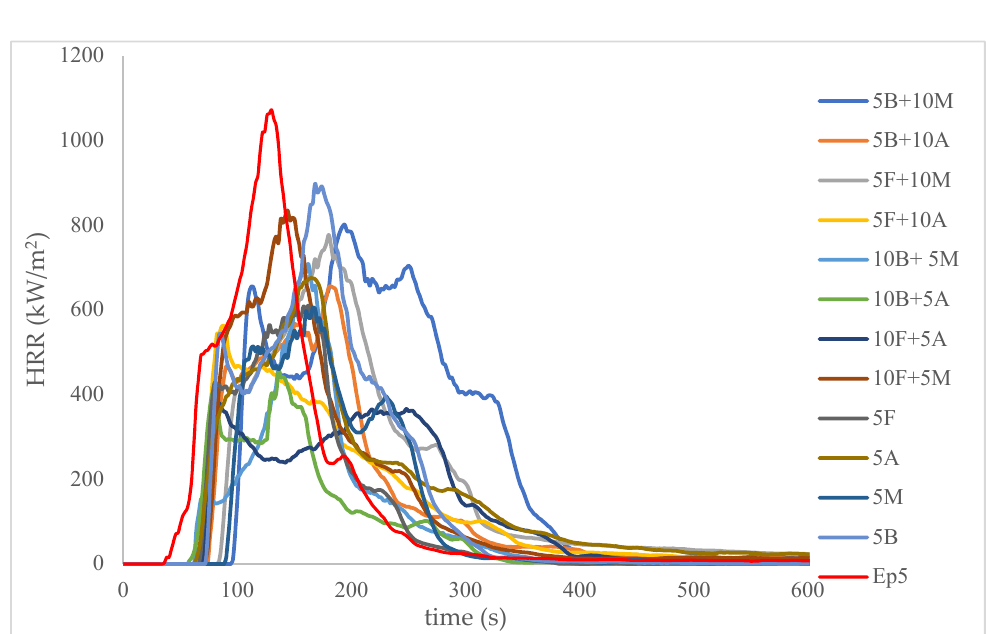
Figure 1. Heat release kinetics of unmodified and modified epoxy material at a heat flux of 30 kW/m 2 in gas phase ignition conditions .